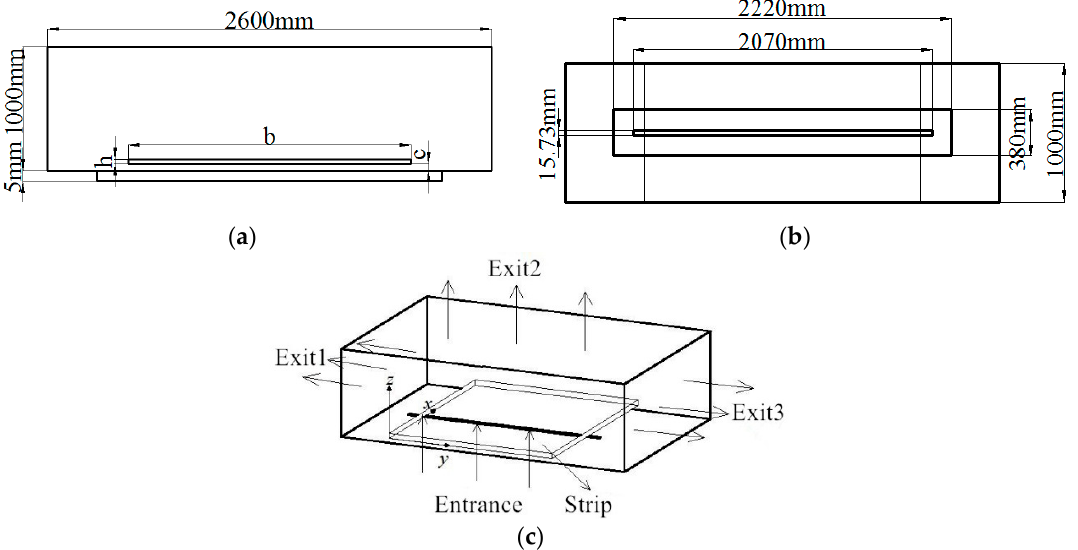
Figure 3. Flow field model diagram: ( a ) front view; ( b ) bottom view; ( c ) three-dimensional view.